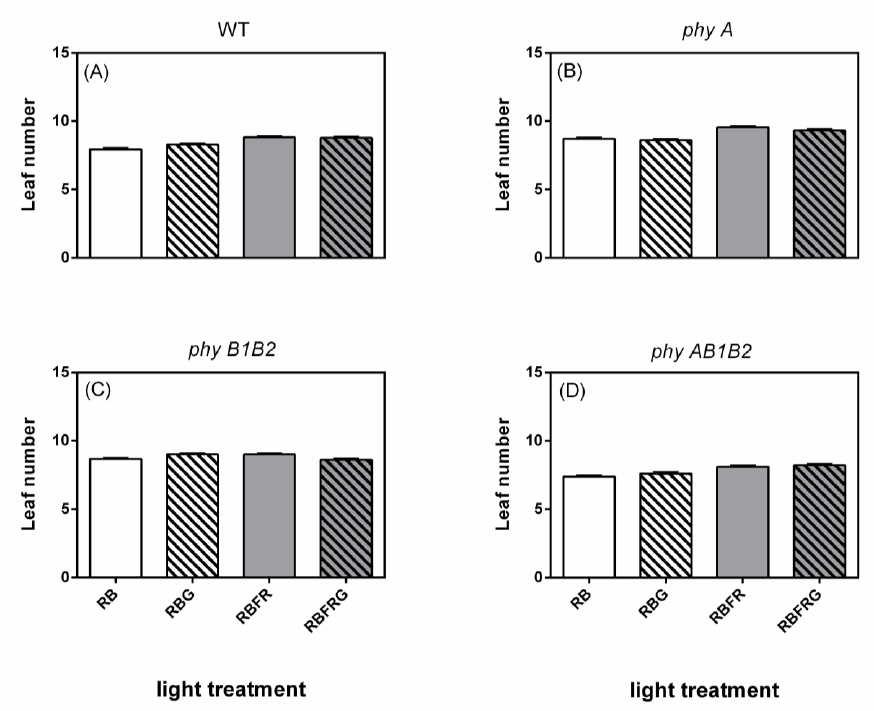
Figure A2. Effects of partial (20%) substitution of red/blue (RB; 3:1) with green (G) light while keep- ing the PSS constant on the total dry mass (exclude root) of tomato plants 21 days after treatment. Four genotypes were studied: WT (Moneymaker; wild-type), phyA (phytochrome A-deficient), phyB1B2 (phytochrome B1- and B2-deficient), and phyAB1B2 (phytochrome A-, B1-, and B2-defi- cient). Light treatment and genotype did not significantly interact ( p = 0.501), but the effects of gen- otype were significant ( p = 0.003). Lower case letters indicate significant differences among the com- binations of light treatment and genotype ( p = 0.05). Data presented are averages, with the SE based on 4 blocks ( n = 4), each containing 3 replicate plants (Exp2).